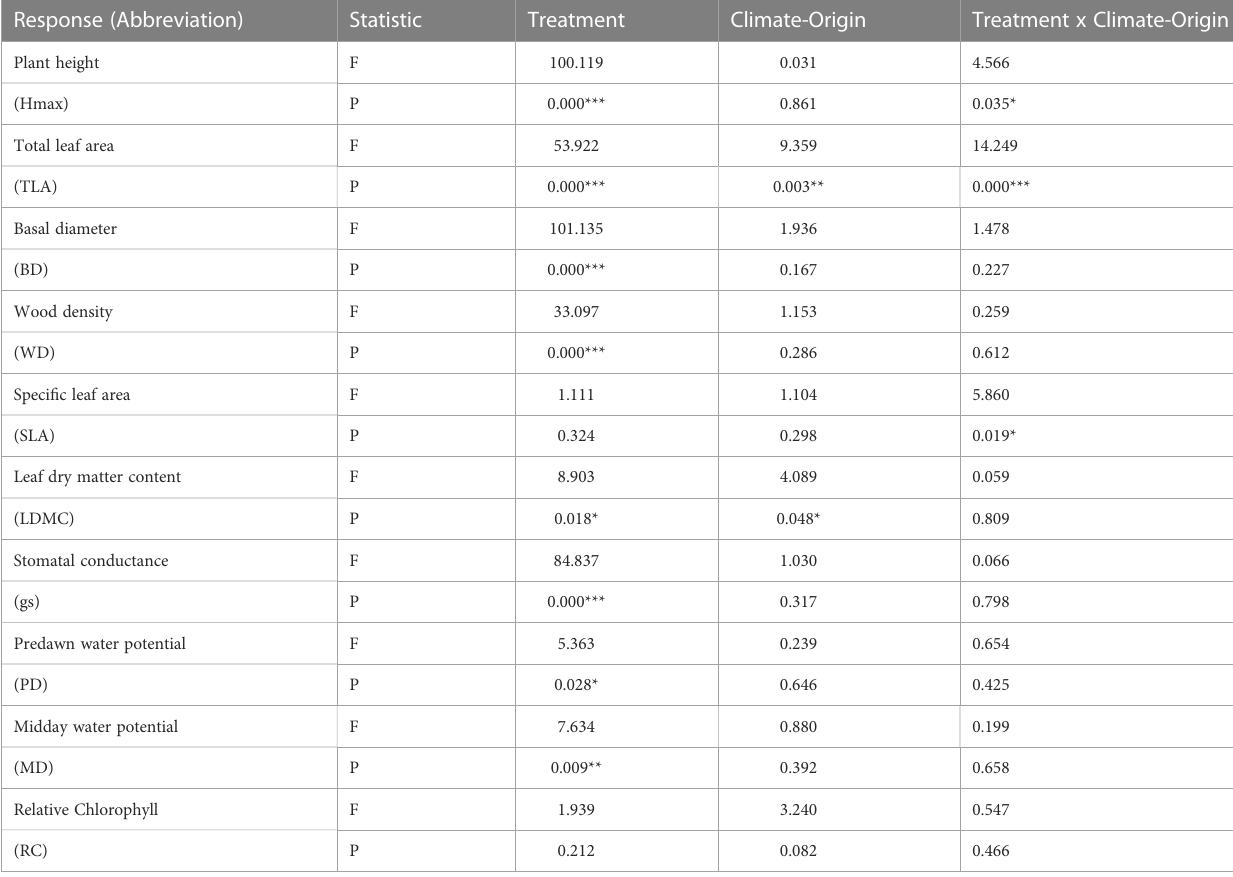
TABLE 1 Analysis of variance testing for effect of water treatment (environment, E), climate-origin (genotype, G) and treatment and climate origin interaction (G x E) on trait expression. Response